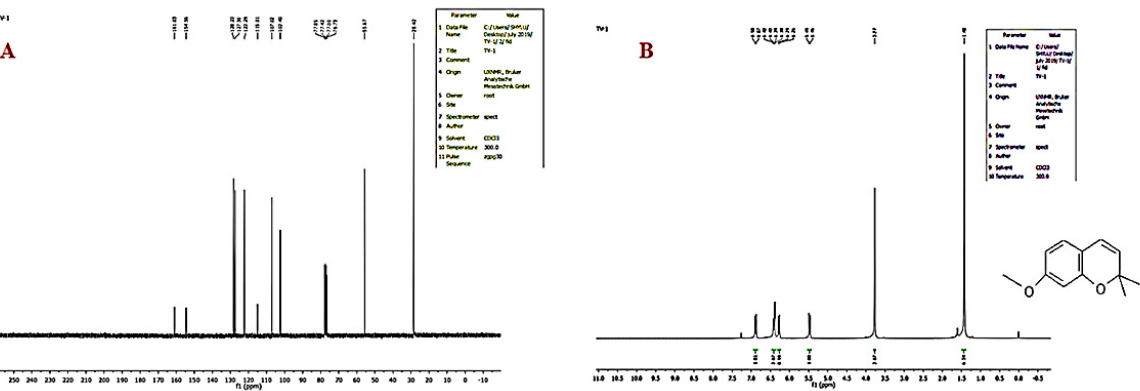
Figure 7. ( A ). 13 C-NMR spectrum of fraction VII (Db-Precocene I), ( B ) 1 H-NMR spectrum of fraction VII (Db-Precocene I).